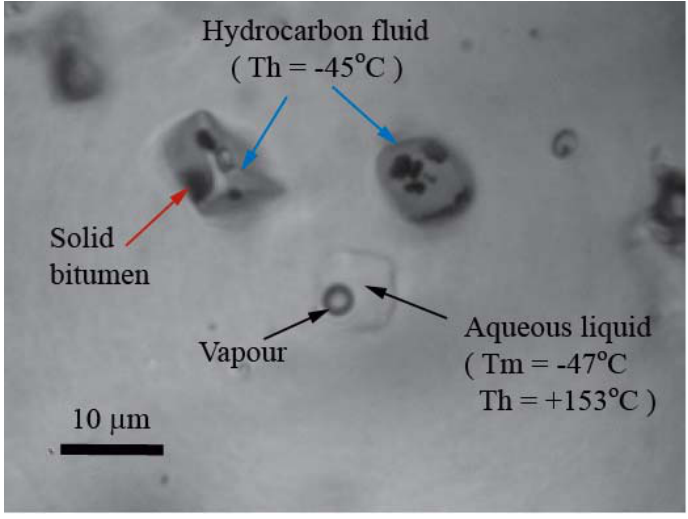
Figure 10. Photomicrograph of fluorite with typical coexisting hydrocarbon and aqueous fluid inclusions from Ersmarksberget. Th = homogenisation temperature, Tm = final ice melting